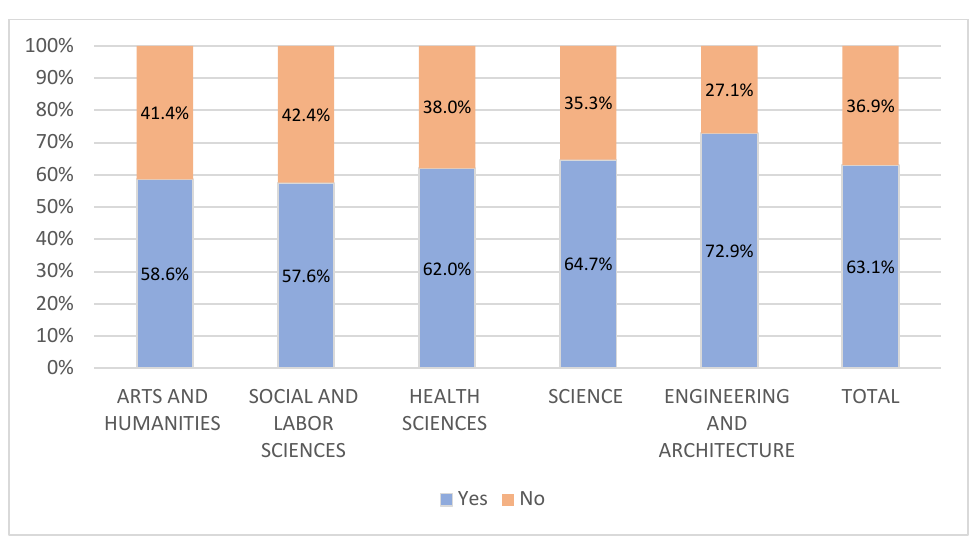
Figure 13. Percentage of use of an online seat reservation system according to branch of study. Among the students who had used some type of online seat reservation system (63.1%), a large majority (88.3%) considered it more effective than placing objects on the seats to indicate occupancy. The spaces with seat reservation systems most used by uni- versity students were cinemas, theaters, auditoriums and other similar venues (82.1%) as well as public transport (80.8%), followed by restaurants (44.9%) and sports stadiums (28.8%), with libraries or study rooms in second-to-last place (17.3%), only ahead of meeting rooms and coworking spaces (9%). 3.2.5. Quality of the Biblio-Smart Prototype An elevated percentage of the students surveyed positively assessed the information provided by the Biblio-Smart prototype. More than 70% believed that it was useful for the user, suitable for the choice of seat to be reserved, pleasing to consult, a mark of ex- cellence for the institution that offers it, and that it met the needs and requirements of the user. Figure 14 illustrates this positive evaluation, with special emphasis on the suitabil- ity of the system for choosing the seat to be reserved (85.7) and the usefulness for the user (84.9%). Figure 14. Assessment of the quality of the Biblio-Smart prototype.